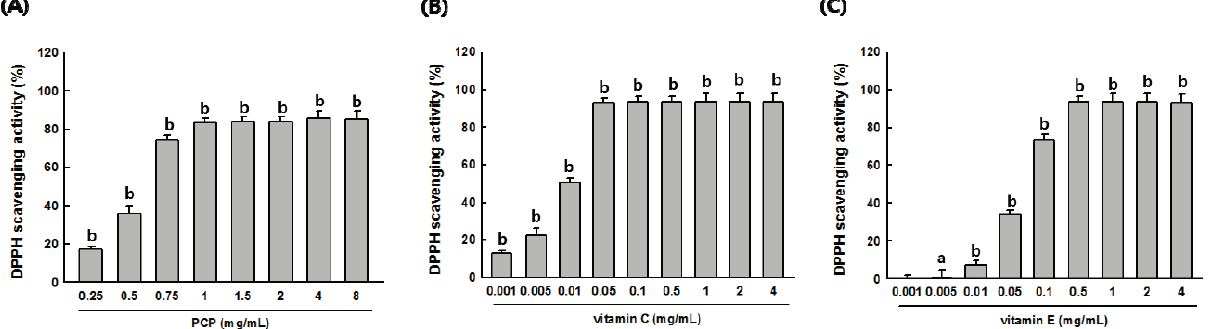
Figure 2. Antioxidant characteristics of PCP. DPPH scavenging activity was examined at ( A ) PCP concentrations of 0.75, 1, 1.5, 2, 4, and 8 mg/mL; ( B ) vitamin C concentrations of 0.01, 0.05, 0.1, 0.5, 1, 2, and 4 mg/mL; and ( C ) vitamin E concentrations of 0.01, 0.05, 0.1, 0.5, 1, 2, and 4 mg/mL. Values are expressed as the means ± SD from three independent experiments. PCP, pomegranate concentrate powder; Vit C, vitamin C; Vit E, vitamin E; DPPH, 1-diphenyl-2-picrylhydrazyl radical; 2,2-diphenyl-1-(2,4,6-trinitrophenyl)hydrazyl; ABTS, 2,3-azinobis (3-ethyl-benzothiazoline-6-sulfonic acid. a p < 0.05 or b p < 0.001 compared with the control (veh) using the Mann-Whitney U